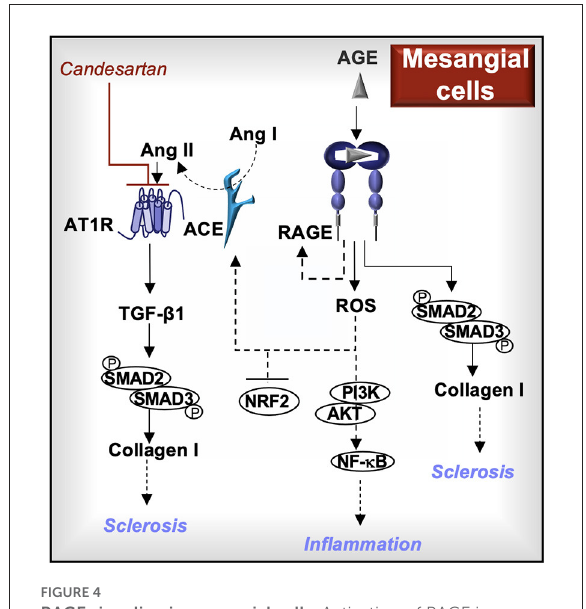
FIGURE4 RAGE signaling in mesangial cells . Activation of RAGE in mesangial cells further increases RAGE production and induces the generation of reactive oxygen species (ROS). The downstream effects of RAGE-induced ROS may include enhanced PI3K/AKT/NF-kB cell signaling, reduced production of the antioxidant transcription factor, nuclear factor erythroid 2-related factor 2 (NRF2), and increased angiotensin-converting enzyme (ACE) activity. ACE cleaves angiotensin I (Ang I) into Ang II, which activates the Ang II type I receptor (AT1R) and induces the production of transforming growth factor (TGF)- β 1. Both TGF- β 1 and RAGE induce the phosphorylation of SMAD2 and SMAD3, which are involved in the production of type I collagen. AT1R blockers (e.g., candesartan) and/or RAGE inhibitors may reduce the development of sclerotic lesions and inflammation associated with